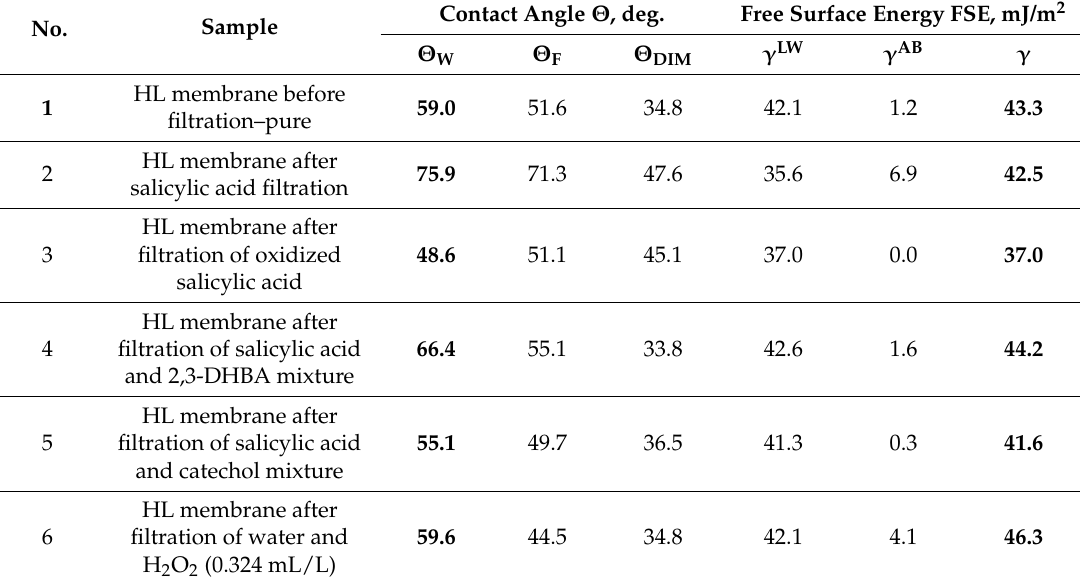
Table 5. Average values of contact angle for three standard liquids and free surface energy of pure HL membrane and membrane after salicylic acid filtration.